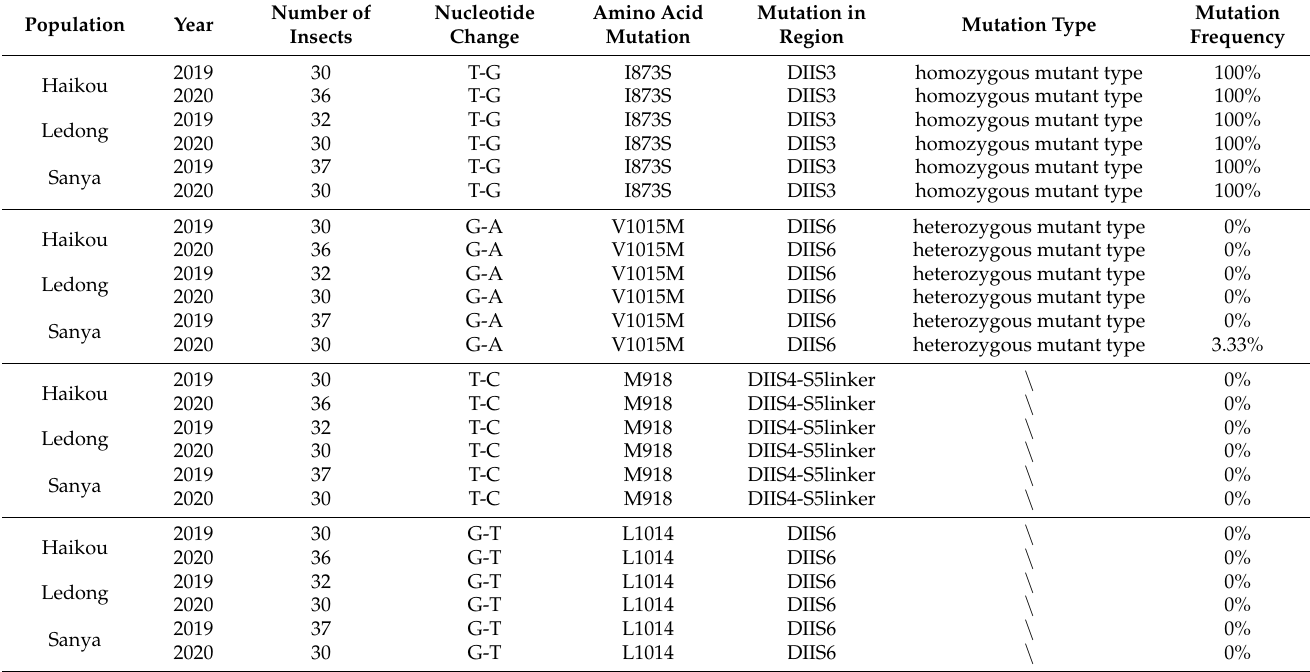
Table 2. Allele frequencies of I873S, M918, L1014 and V1015M mutant genotypes in six field popula-